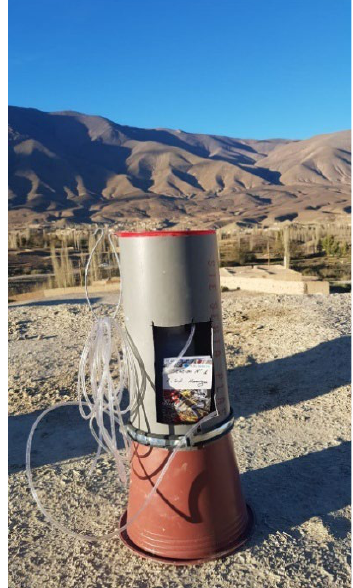
Figure 3. Rain collection system.